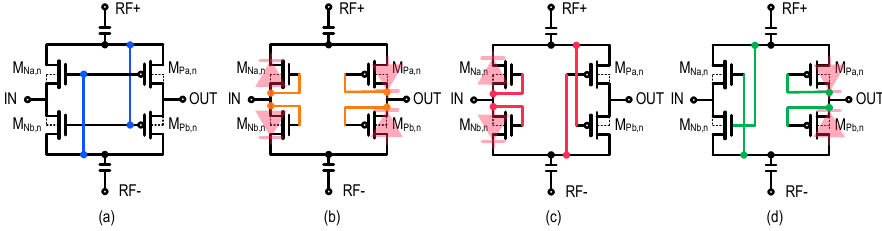
Figure 1. The different configurations of a rectifier: ( a ) conventional CCDD, ( b ) diode-connected dual path rectifier, ( c ) hybrid topology (NDPS), ( d ) hybrid topology (NSPD).